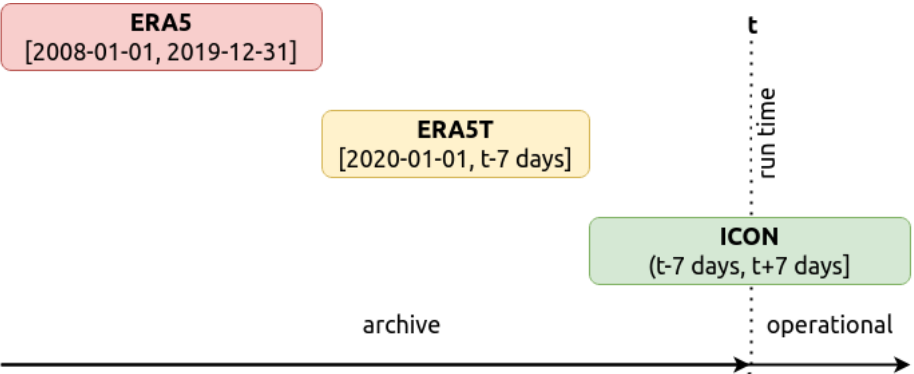
Figure 2. Illustration of data flows during the process of runoff forecast